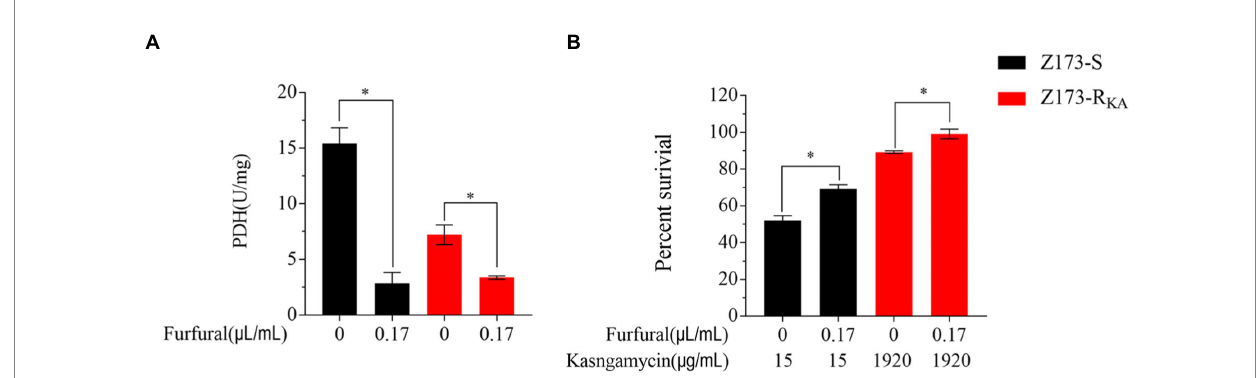
FIGURE 5 Analysis of P cycle in the presence of inhibitor. (A) Enzymatic activity of PDH of Z173-S and Z173-R KA in the presence or absence of 0.17 μ L/mL furfural. (B) Percentage of survival of Z173-S and Z173-R KA in the presence of the indicated concentrations of furfural plus 15/1,920 μ g/mL KA. Results are reported as mean ± SD, and p -values are identified (* p < 0.05) as determined by the two-tailed Student’s t -test. At least three biological repeats were carried